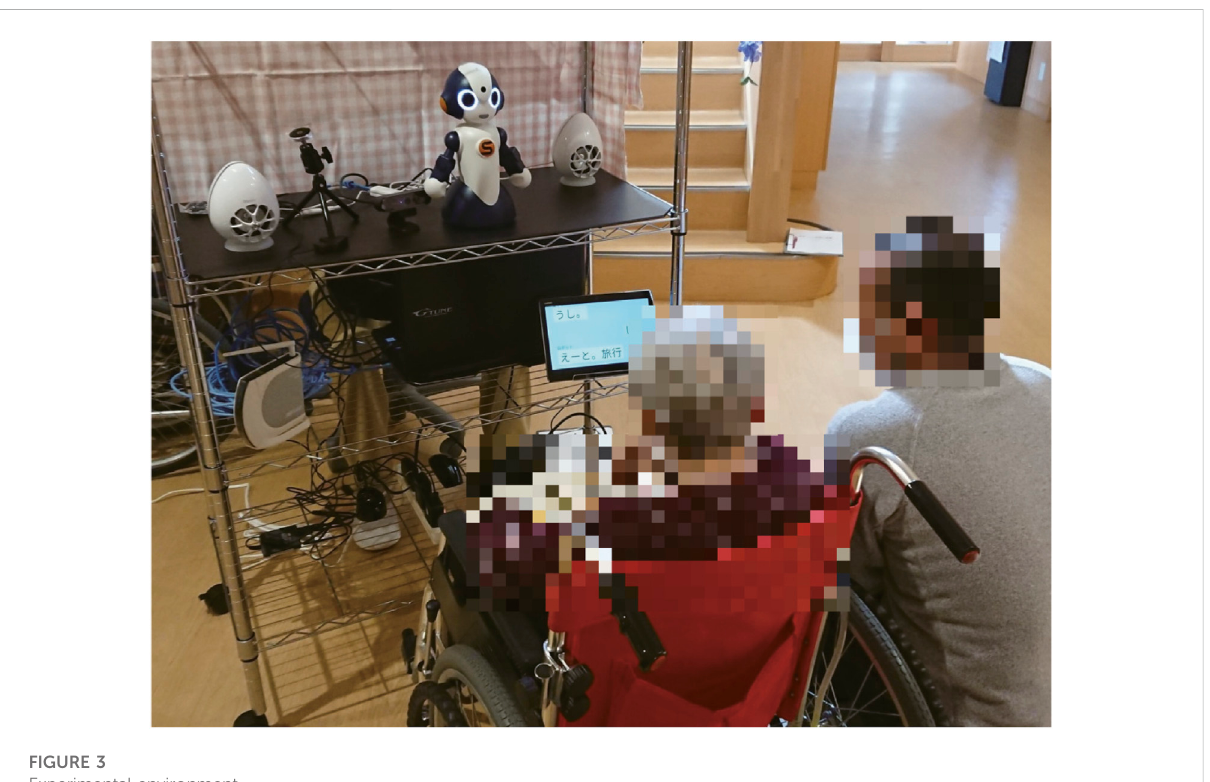
FIGURE 3 Experimental